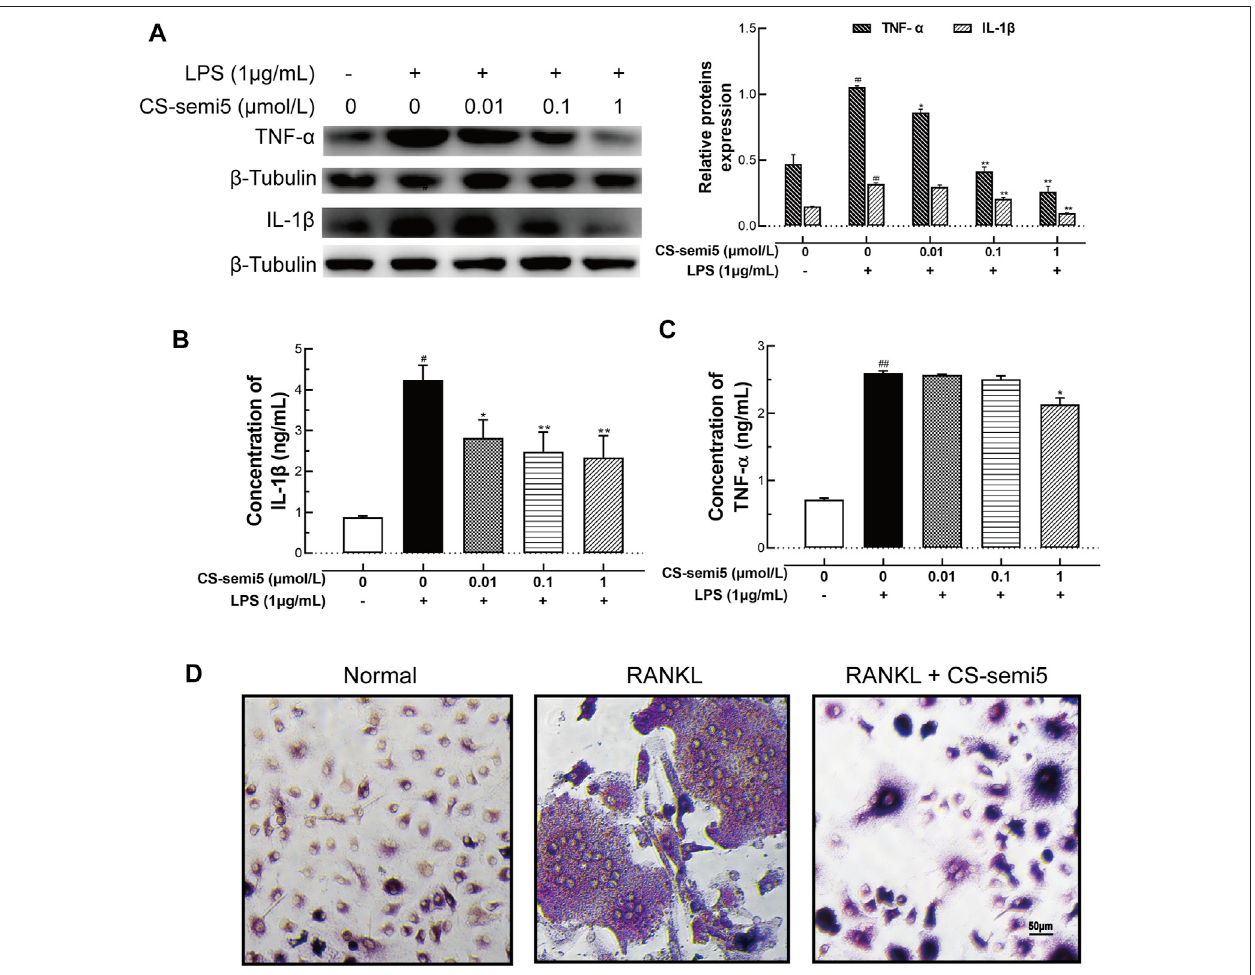
FIGURE 6 | CS-semi5 downregulates TNF- α and IL-1 β production and blocks osteoclast differentiation in RAW264.7 cells. (A) RAW264.7 cells were incubated with or without LPS (1 μ g/ml) for 24 h. Secretion of TNF- α and IL-1 β proteins was evaluated by western blot assay. (B,C) Secretion of TNF- α and IL-1 β proteins was evaluated by ELISA. (D) RAW264.7 cells were cultured for 7 days with RANKL (50 ng/ml) or CS-semi5 (1 μ mol/ml), then stained for TRAP activity. Bar indicates 50 μ m n (cid:1) 3. # p < 0.05 and ## p < 0.01 compared with Control Group; * p < 0.05 and ** p < 0.01 compared with LPS stimulation Group.